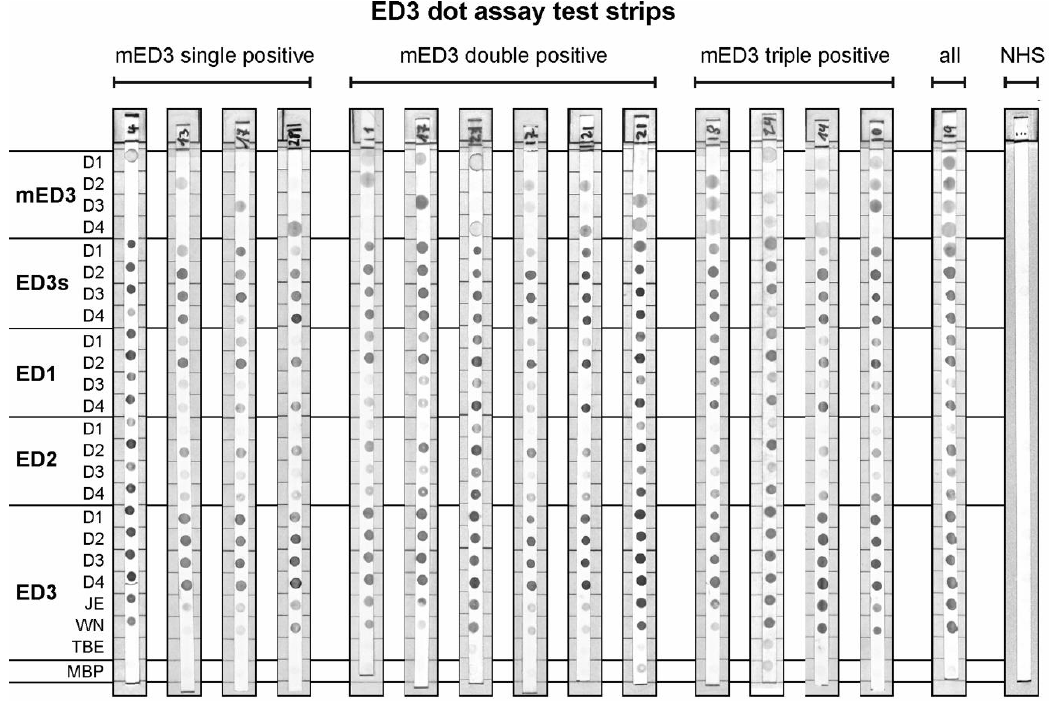
Figure A2. Original test strips including antigen dots for ED1, ED2, ED3, ED3s and mED3.